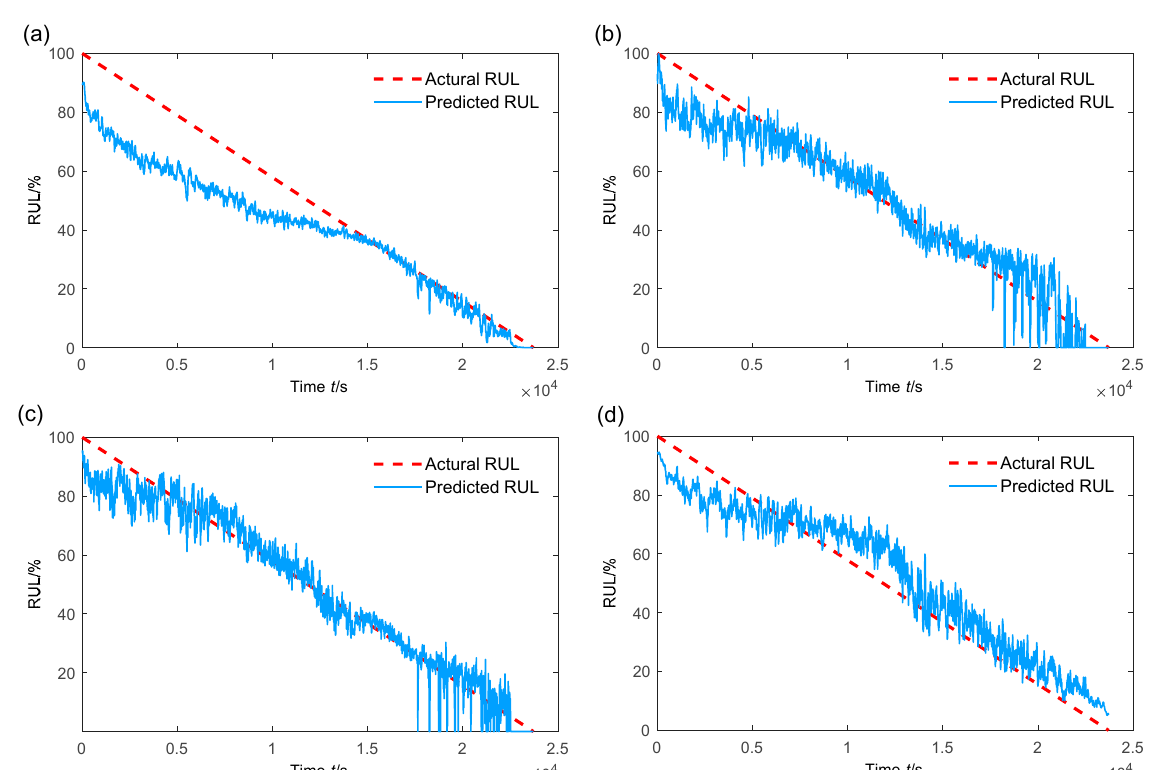
Figure 13. RUL prediction results of bearing1_3 for four prognostics approaches: ( a ) ResNets; ( b ) CLSTM; ( c ) MS-DCNN; and ( d ) MS-DRN.